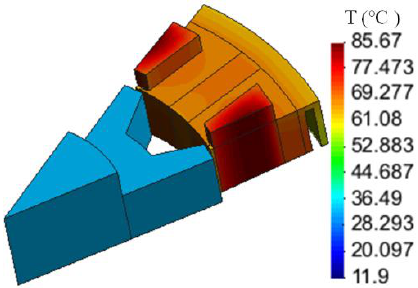
Figure 16. Temperature distribution of FSPM machine.